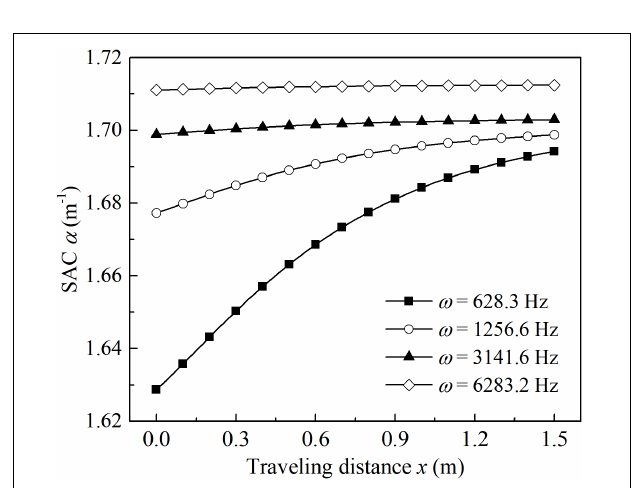
FIGURE 6 | Frequency-dependent spatial attenuation coefficients versus traveling distance ( σ s = 5.09 MPa).